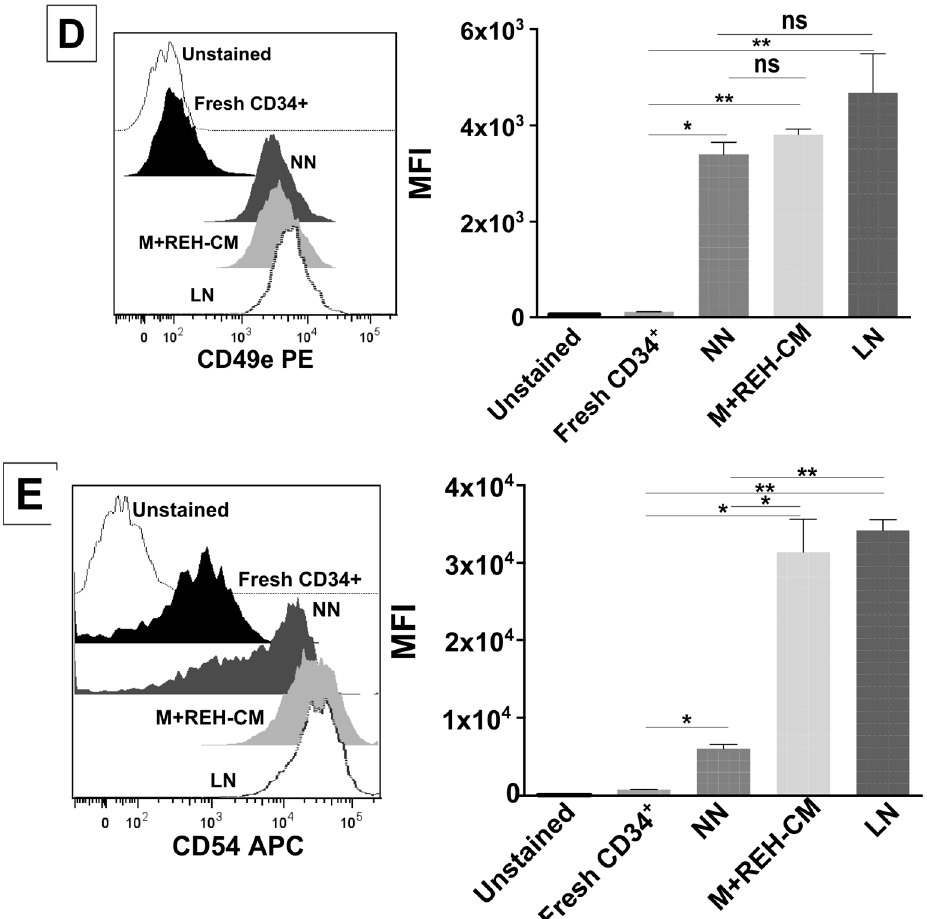
Figure 2. Increased adhesion capacity and expression of some adhesion molecules in CD34+ cells in the LN. ( A ) MSC adhesion capacity evaluation of CFSE-labelled CD34+ cells obtained from the NN or the LN; cells were cultured with MSC for 4 h and counted by fluorescence microscopy. The percentage of adhered cells was calculated taking into account the total input of CD34+ cells (* p < 0.05). Labelling of ( B ) CD44, ( C ) CD49d, ( D ) CD49e, and ( E ) CD54 in freshly-isolated, NN, M+REH-CM, and LN CD34+ cells. Results are expressed as the median fluorescence intensity (MFI) from two independent experiments done in triplicates ( n = 6) (ns: non-significant, * p < 0.05, ** p < 0.01, *** p < 0.001).